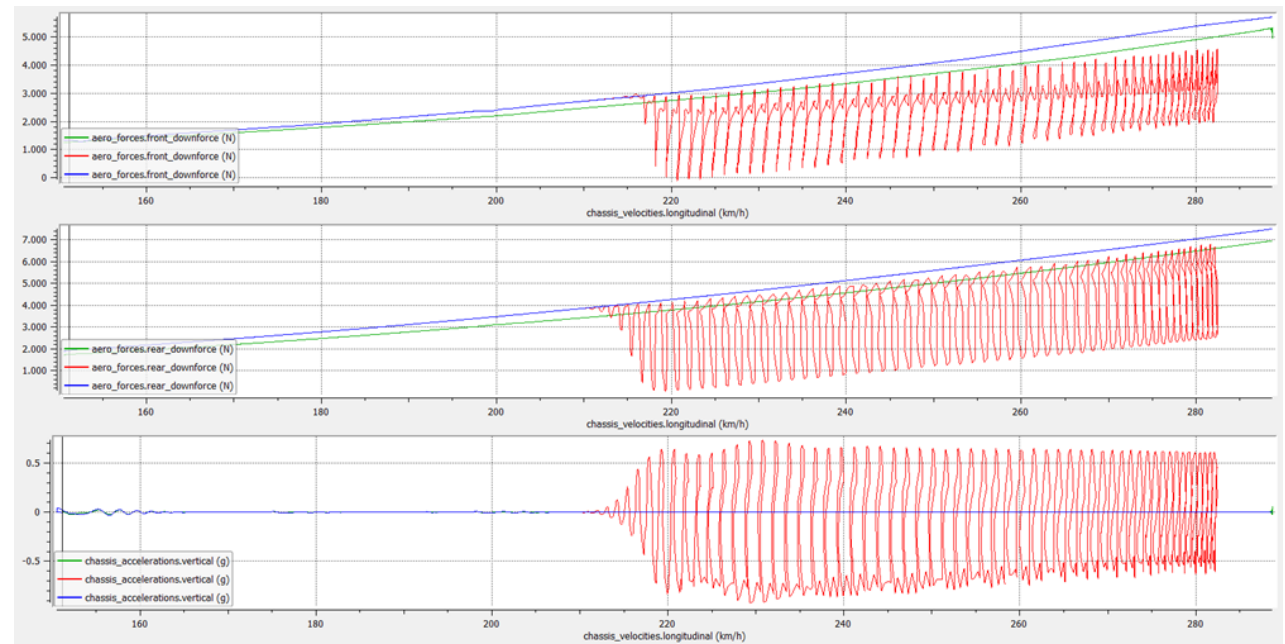
Figure 28. Vehicle body motion with static ride height variations FRHS +10 mm, RRHS +20 mm (#4, green) vs. baseline configuration plus decay functions (#2, red) and without (#1, blue). Changes to ride heights and their effects are clearly visible: porpoising is fully removed. In this plot FRH ( top ), RRH ( center ), and pitch variation ( bottom ) are shown.